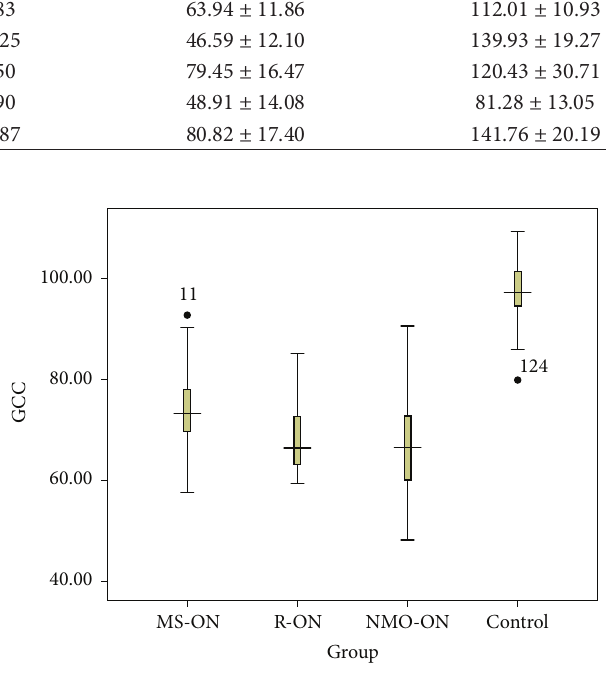
Figure 1: The boxplot analysis representing the macular GCC thickness in MS-ON, R-ON, NMO-ON, and control group. Mean values and 5% and 95% percentiles are shown. The difference between the 4 groups was statistically significant ( 𝑃 < 0.001 ), whereas there was no significant difference between R-ON and NMO-ON group ( 𝑃 = 0.725